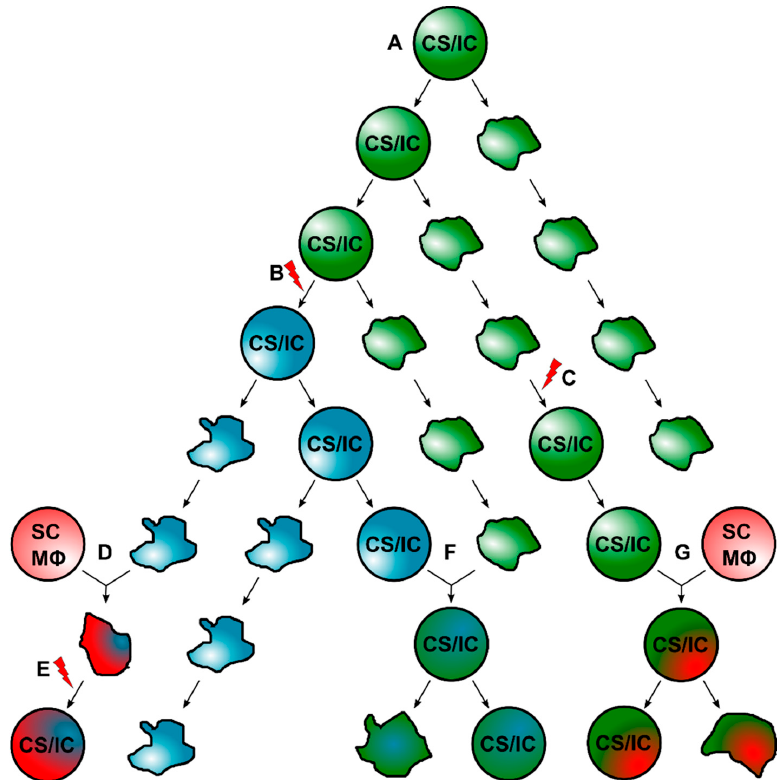
Figure 3. Promotion of intratumoral heterogeneity through cell–cell fusion and generation of CS/ICs. ( A ) Primary tumor formation is initiated by the initial CS/IC, which could self-renew and can give rise to differentiated proliferating cancer cells. ( B ) Due to mutational events, a new subclone CS/IC could originate from the initial CS/IC. ( C ) A non-CS/IC could convert into a CS/IC due to intrinsic/extrinsic processes, such as EMT. ( D ) Cancer cells could fuse with normal cells, such as stem cells or macrophages, thereby giving rise to tumor hybrid cells, which then ( E ) might gain a CS/IC phenotype due to intrinsic/extrinsic processes. ( F ) Intratumoral fusion of an existing subclone CS/IC and a tumor cell results in the formation of a new subclone CS/IC. ( G ) A subclone CS/IC fuses with a normal cell, such as a stem cell or a macrophage, which also results in the origin of a new subclone CS/IC. The red lightning should indicate mutational events.